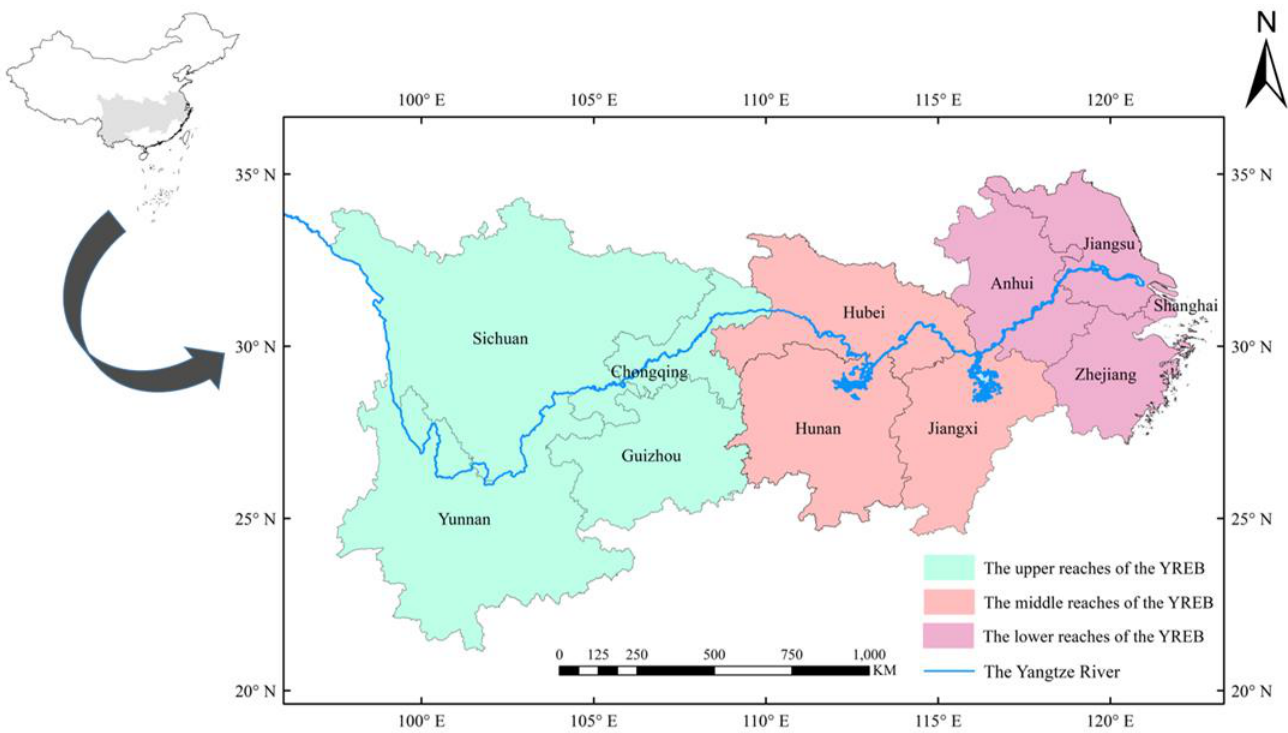
Figure 1. Location map of Yangtze River economic belt.